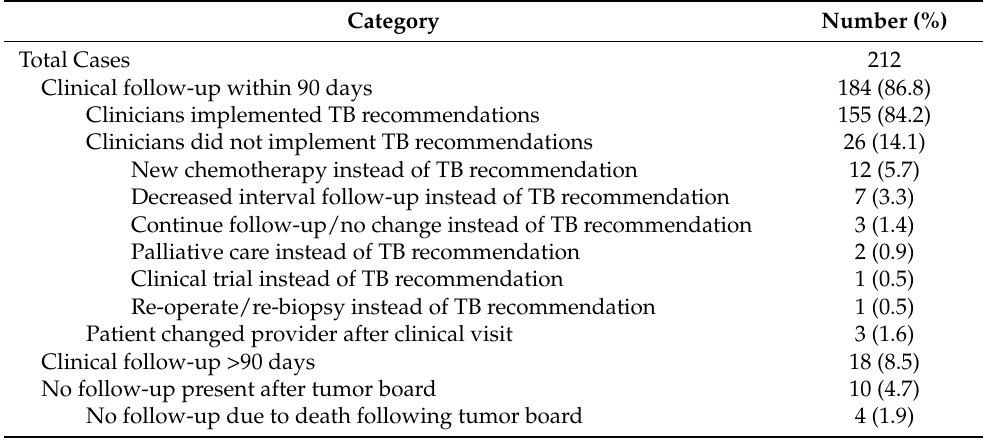
Table 3. Tumor board recommendation implementation.